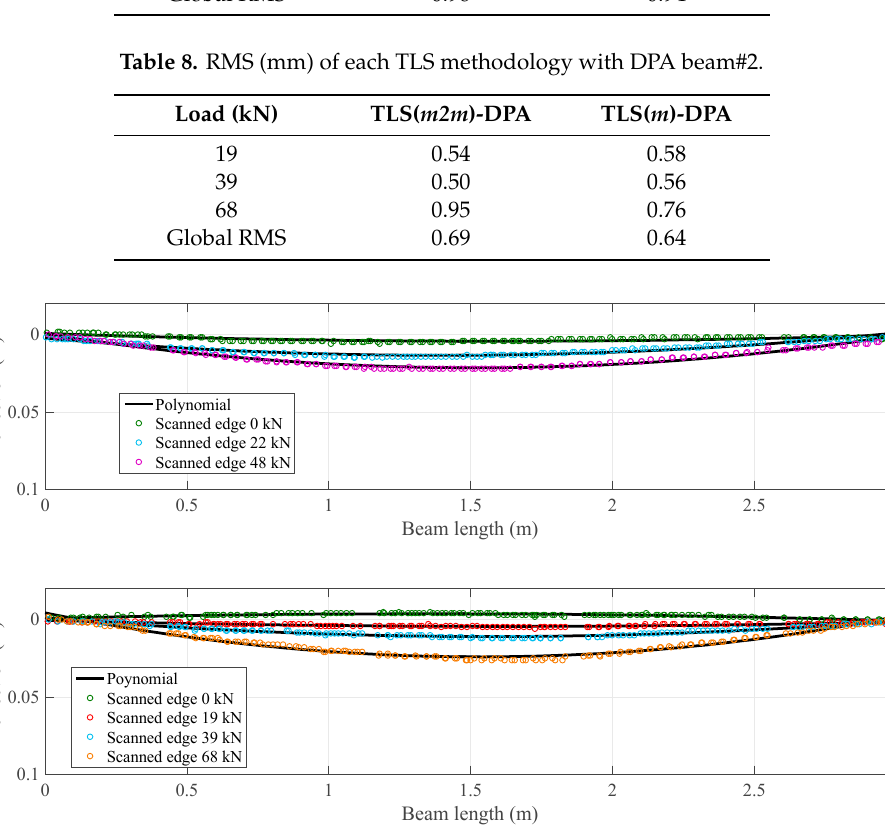
Figure 12. Terrestrial Laser Scanners ( TLS) polynomials fitted along the beam span for beam#1 LC2 ( top ) and beam#2 ( bottom ). The rounded markers represent a selection of the mesh points used in the fitting process.